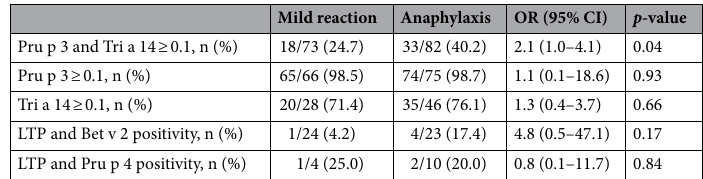
Table 4. Association between type of clinical presentation and specific IgE positivity.